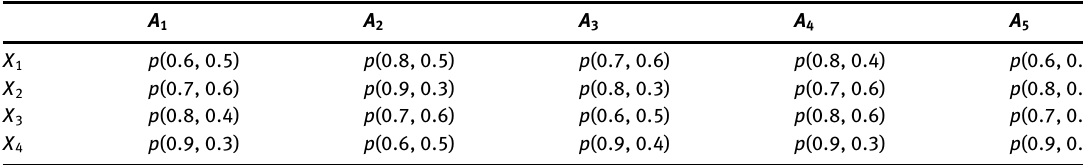
Table 6: Pythagorean Fuzzy Decision by Decision Maker d 3 .